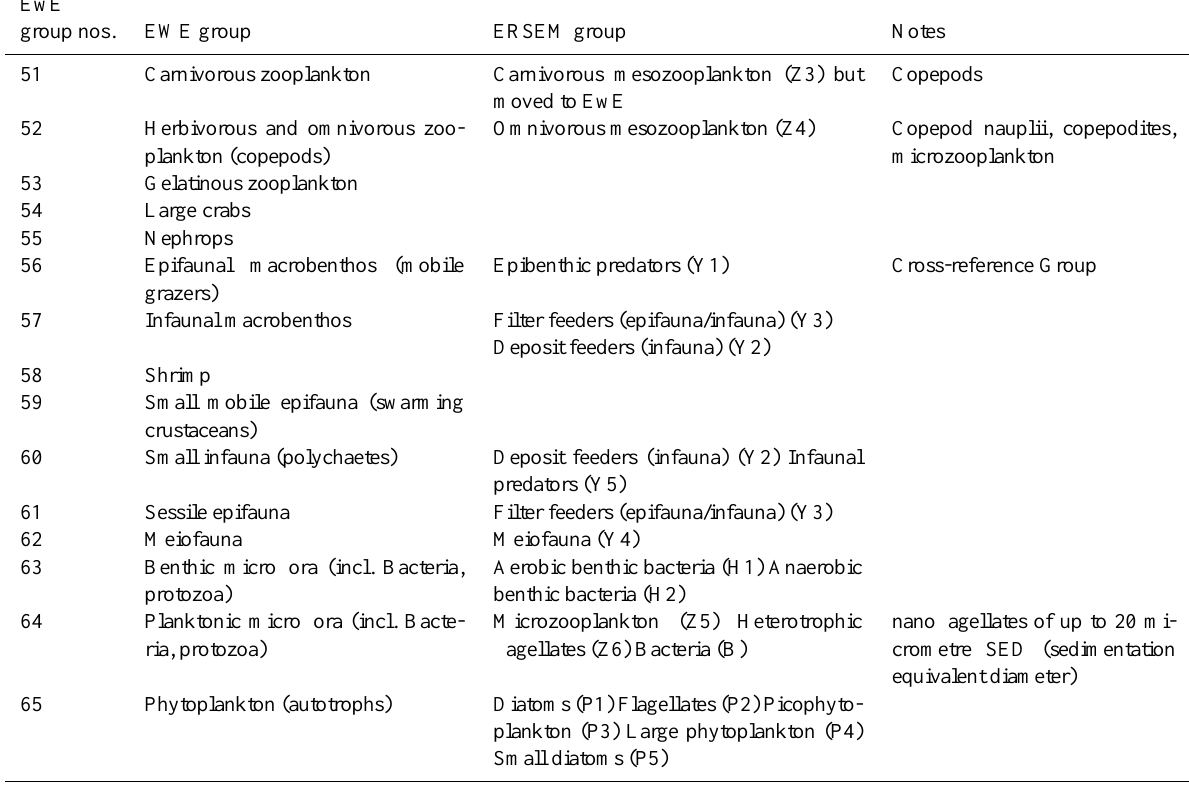
Table 1. ERSEM and EwE function groups mapped EwE group